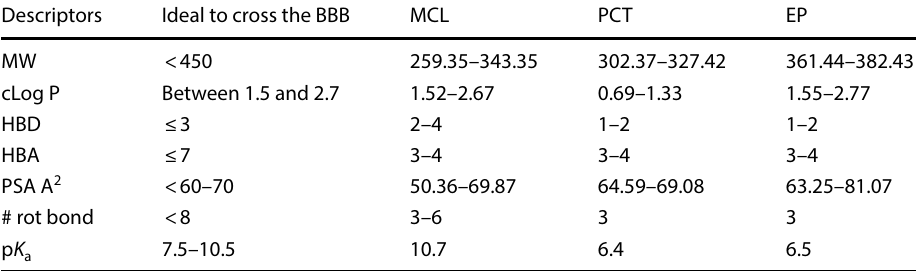
Table 4 Comparison of properties for a fraction of compounds (MCL) in this study and respective ranges considered ideal for CNS